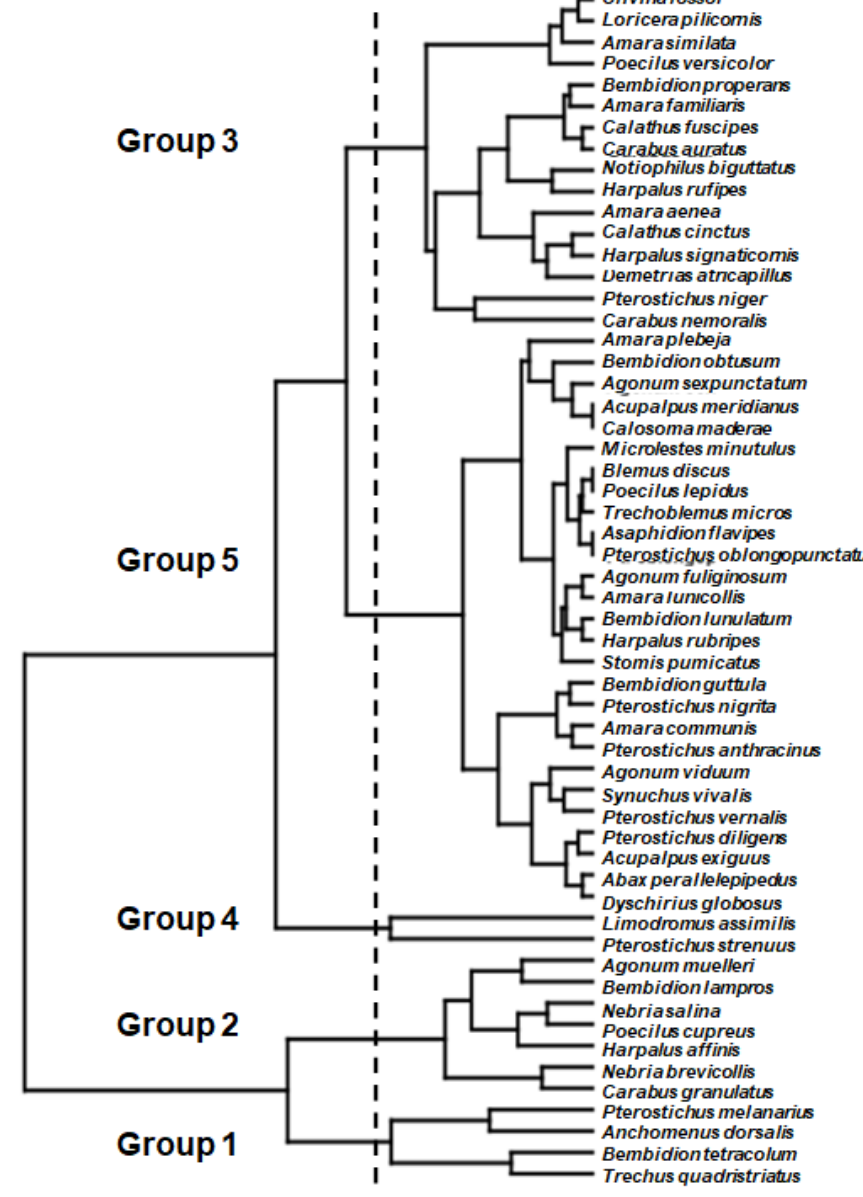
Figure 3. Cluster of species using values for potential forage use (pair-group clustering; Euclidean similarity distance) and separated groups.